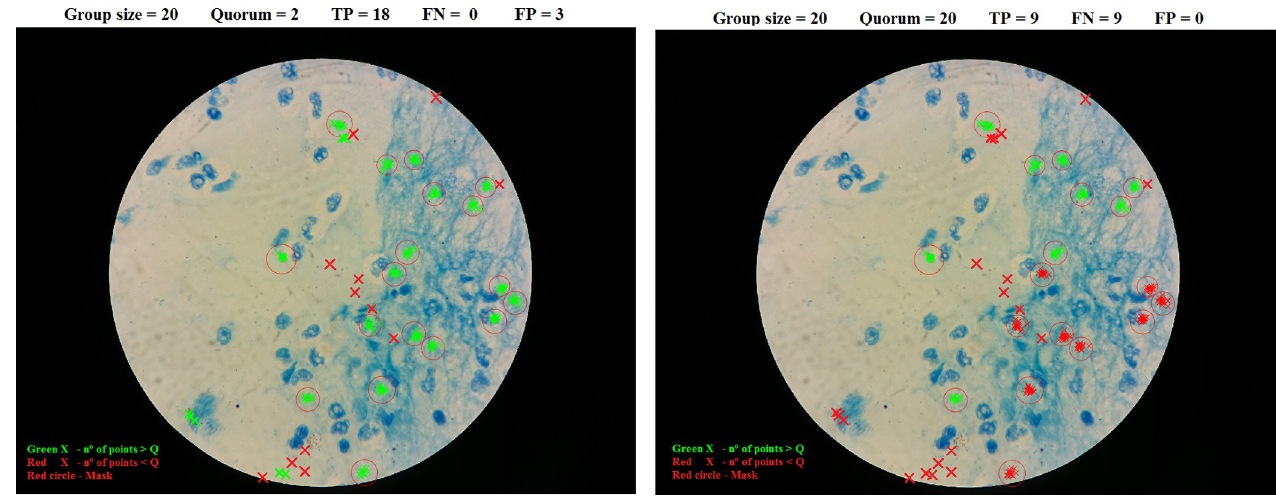
Fig 2. Examples of two different experiments performed on the same field of view, left quorum Q = 2, right quorum Q = 20. Red crosses are clicks that belong to a cluster that have less clicks than the quorum number evaluated in the experiment. Green crosses are clicks that belong to a cluster bigger than the quorum number evaluated. Red circles correspond to confirmed locations of bacilli. TP- true positive, FN- false negative, FP -false positive.